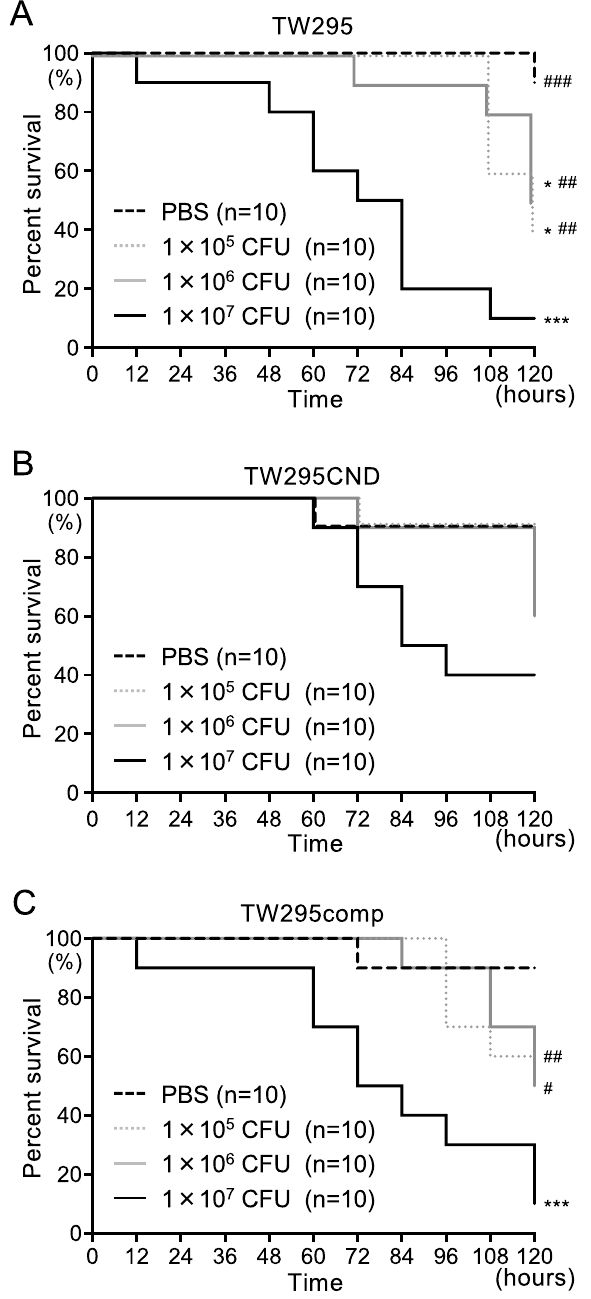
Figure 3. Survival curve for silkworm larvae infected with different doses of live S. mutans . Silkworm larvae infected with ( A ) TW295 (Cnm +), ( B ) TW295CND (Cnm−), and ( C ) TW295comp (Cnm +). Survival rates in each group were evaluated in a Kaplan–Meier plot, which was analyzed by a log-rank test. * P < 0.05 and *** P < 0.001 versus phosphate-buffered saline group; # P < 0.05, ## P < 0.01, and ### P < 0.001 versus 1 × 10 7 CFU of S. mutans administration